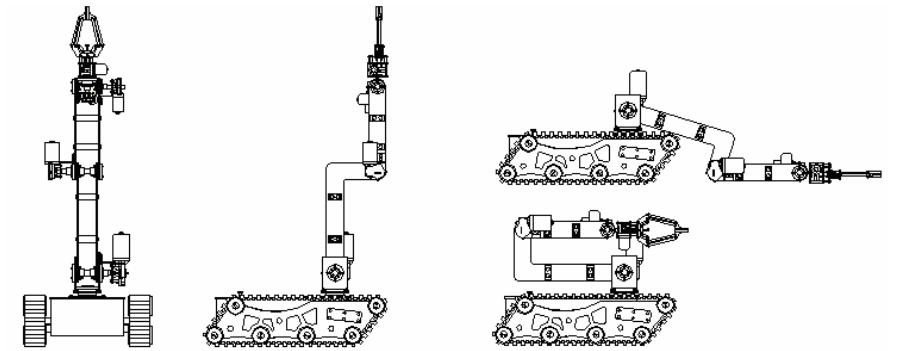
Figure 6 – Technical project of the pyrotechnic robot